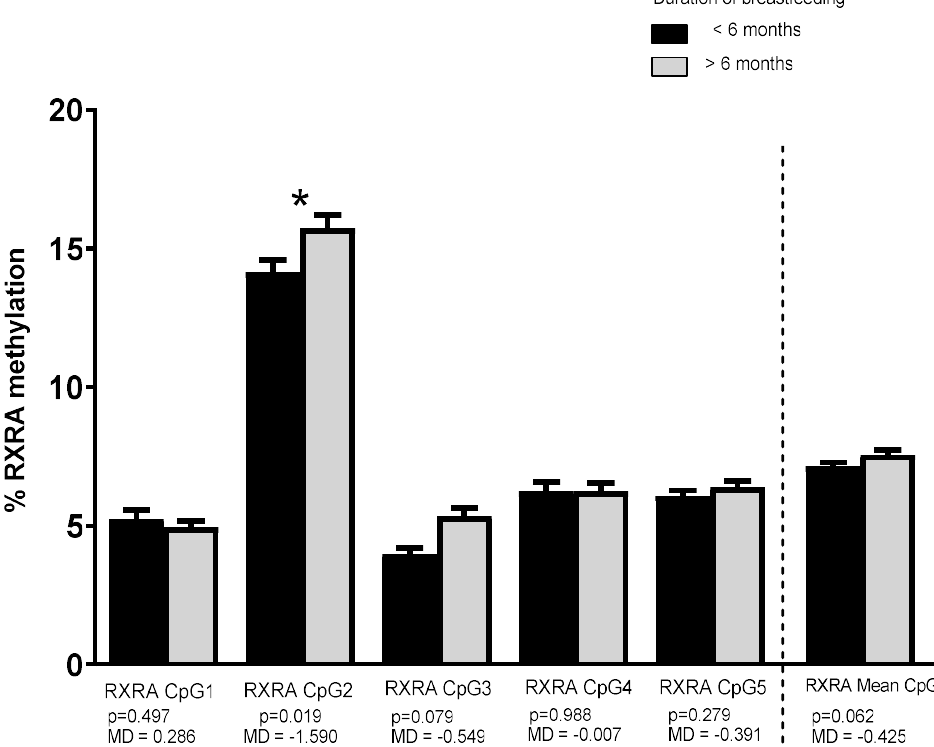
Figure 2. Buccal RXRA methylation by duration of breastfeeding. The bars represent the mean methylation values and standard errors of the mean of the 97 one-year-olds. The results are based on the duration (two categories) of maternal breastfeeding. The p -values and mean di ff erences (MD) are shown. * p ≤